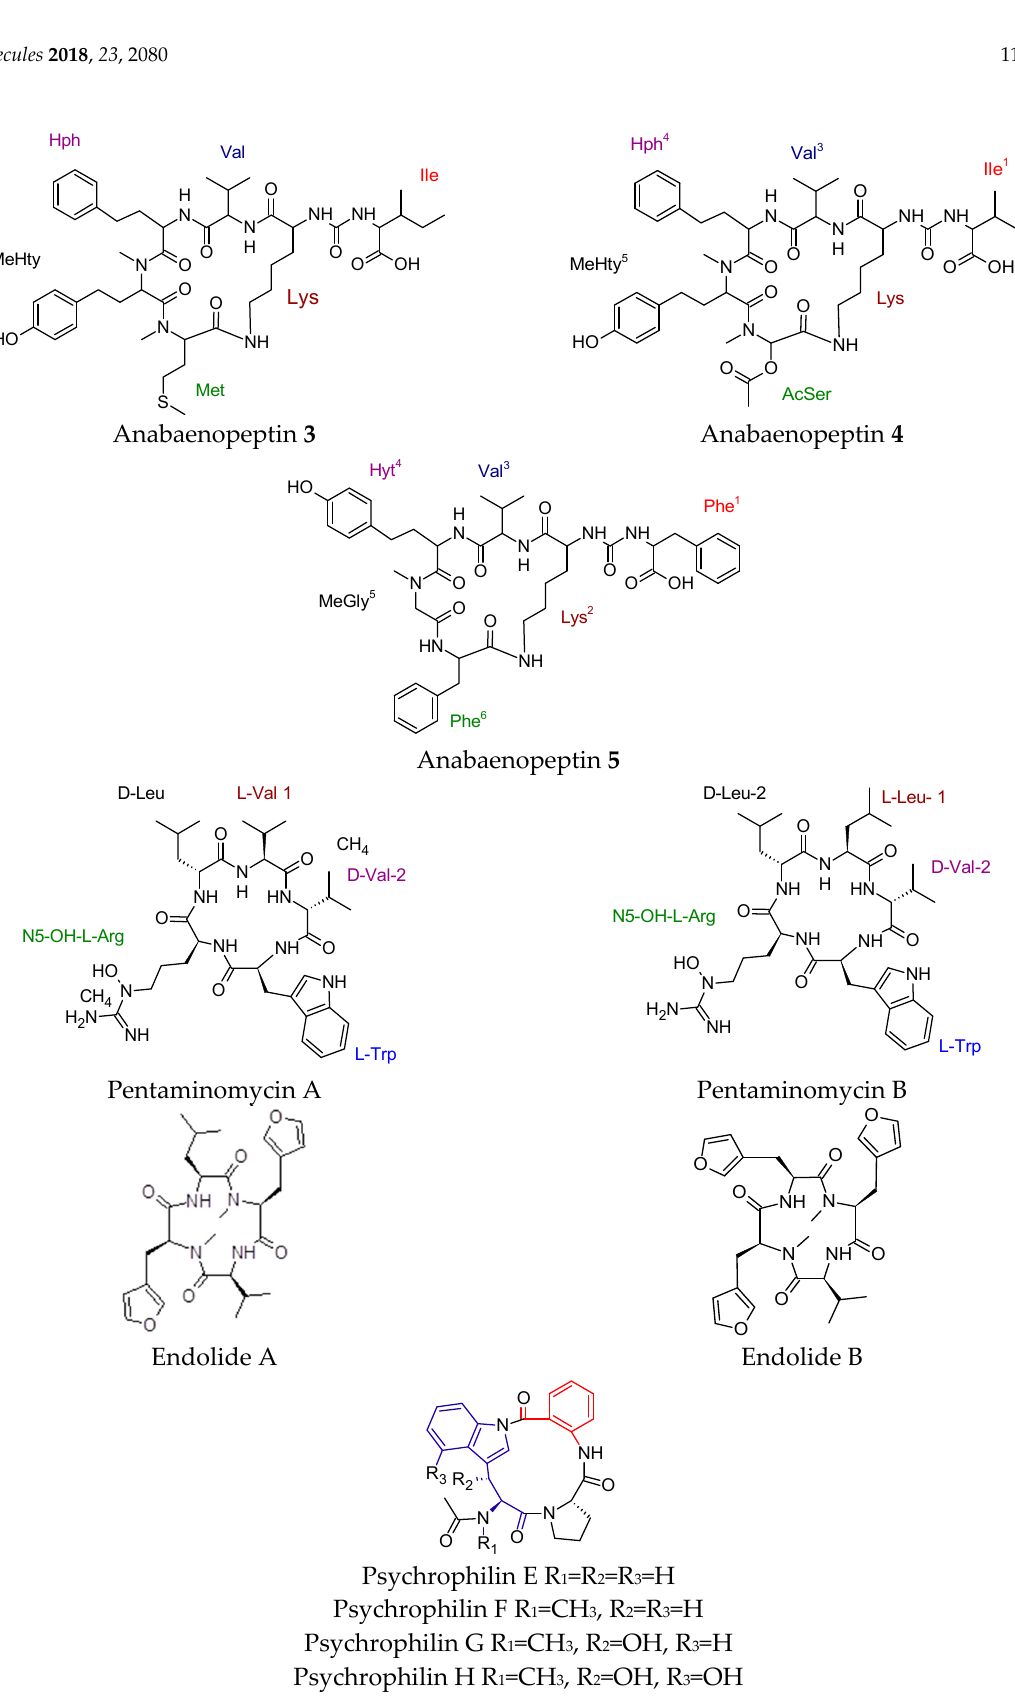
Figure 6. Recently isolated cyclic peptides with diverse biological activities.